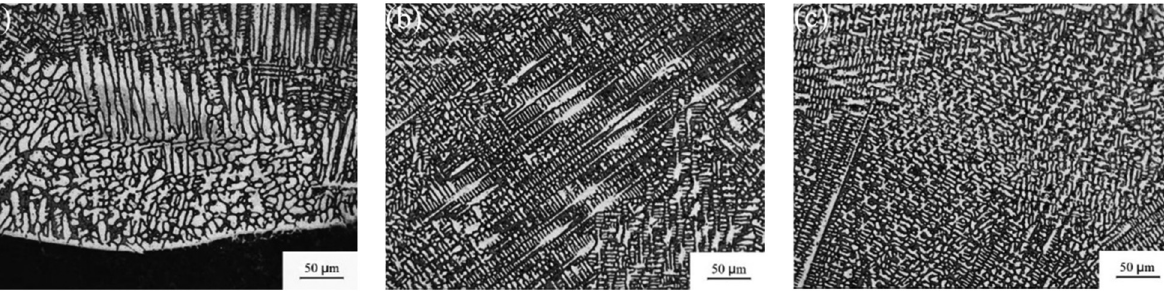
Figure 2: Microstructure of the CL: ( a ) bottom, ( b ) middle, and ( c ) top.